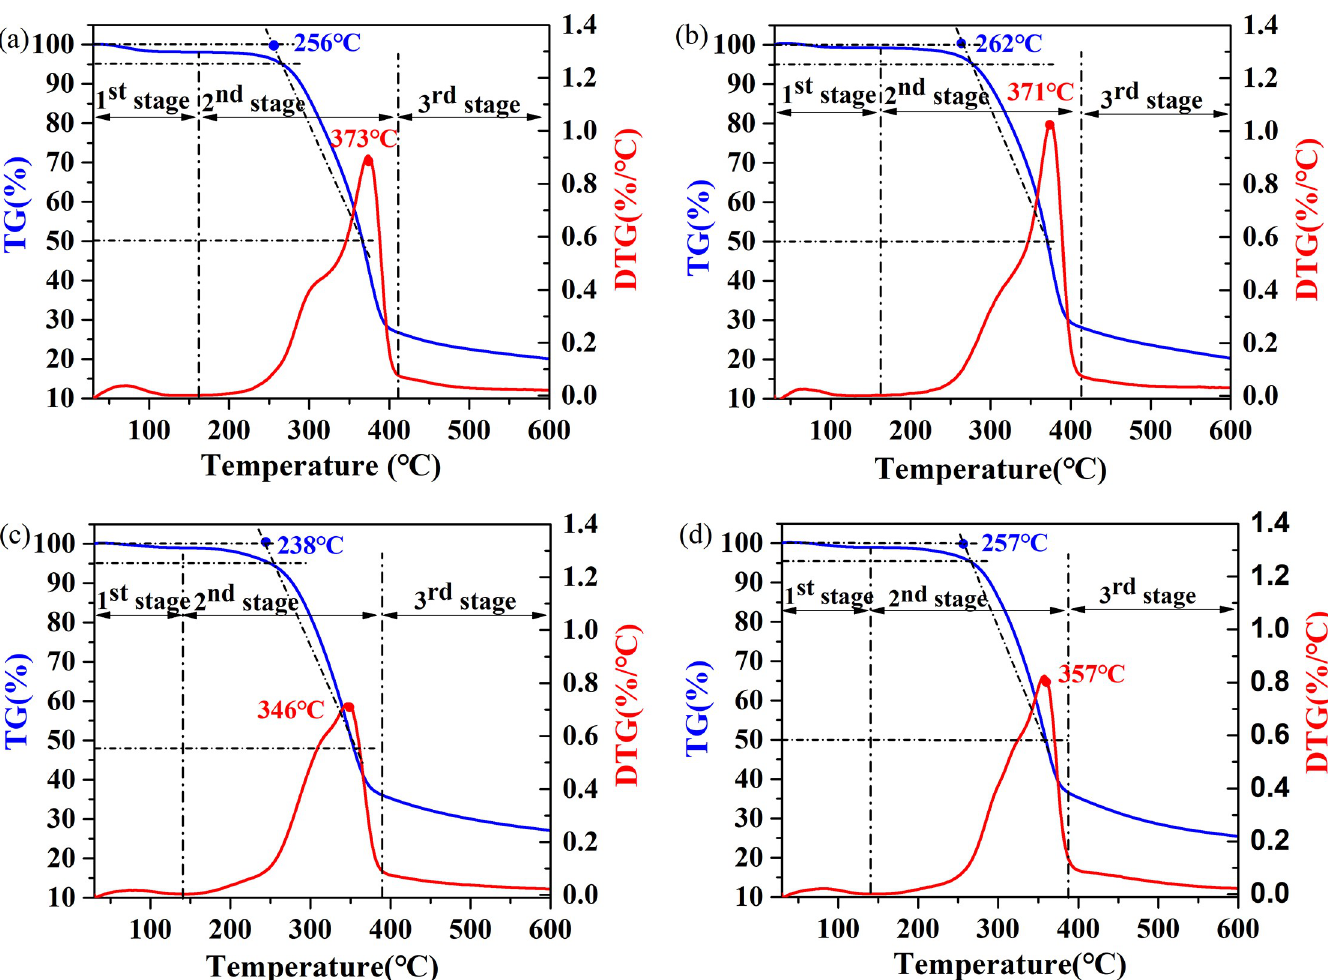
Fig 4. Example of TG and DTG curves. (a) TG and DTG curves for Untreated sample at a heating rate of 20˚C min -1 ; (b) TG and DTG curves for HT sample a heating rate of 20˚C min -1 ; (c) TG and DTG curves for IMPG sample a heating rate of 20˚C min -1 ; (d) TG and DTG curves for IMPG-HT sample a heating rate of 20˚C min -1 .